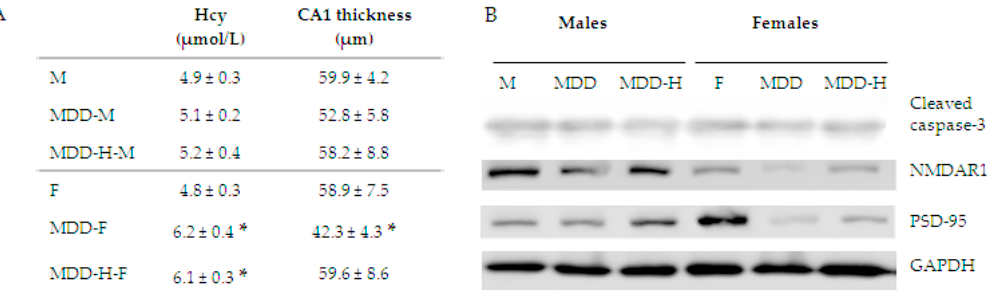
Figure 3. ( A ) Plasma homocysteine in µmol/L ( n = 10 to 15 animals per group) and measurement of hippocampus CA1 layer thickness in µm at 330-days-of-age in each animal groups ( n = 5 animals per group; Statistics, * p < 0.05). ( B ) Western blot analysis of protein expressions in hippocampus extracts at 330-days-of-age in each animal groups ( n = 3 to 5 animals per group, run in duplicate). Cleaved caspase-3, N-methyl D-aspartate receptor-1 and post-synaptic density-95 were analyzed in 4 animals per group, run in duplicate, and compared with GAPDH as internal standard. The blot shown in the figure presents the representative variations observed in all blots. See the decreased expression of NMDAR1 and post-synaptic density-95 (PSD-95) in MDD groups, the restoration of their expression with hypoxia (H) despite MDD, while the level of expression of the cleaved caspase-3 remained comparable. Finally, we explored some molecular markers to evaluate tissue health of the hippocampus area at D330. We found that the physiological mortality represented by the expression of the cleaved-caspase-3 appeared similar in all groups. However, western blot analysis showed that expression of NMDAR1 and PSD-95 appeared lower in MDD males and females compared to their controls respectively. These markers were over-expressed in hypoxia groups (MDD-H males and females) compared to MDD groups in respect to gender.